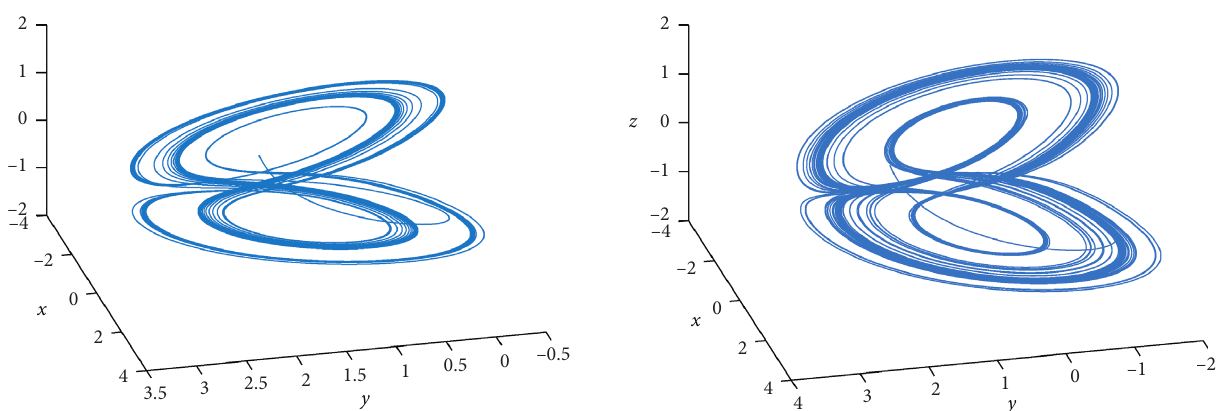
Figure 4: Dynamic behavior of fractional financial chaotic model with α � 0 . 95.